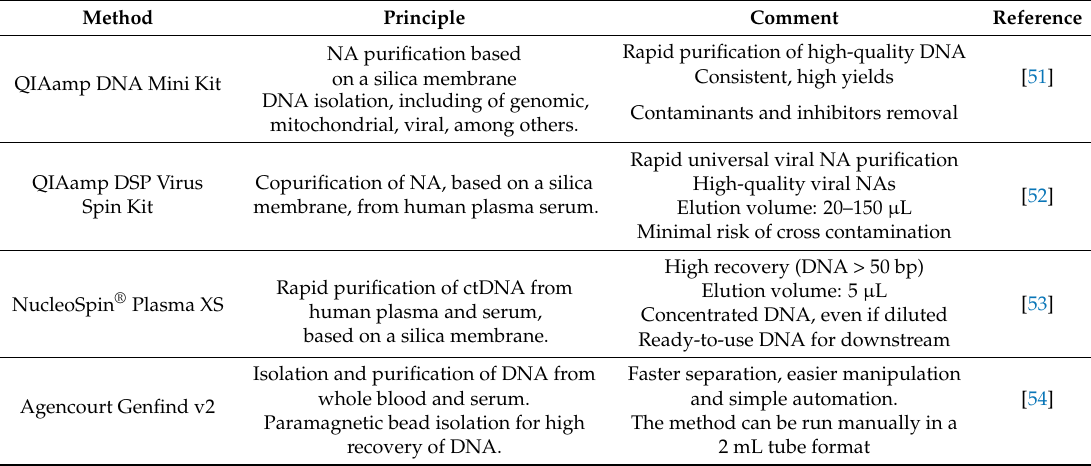
Table 1. Commercial techniques for NA